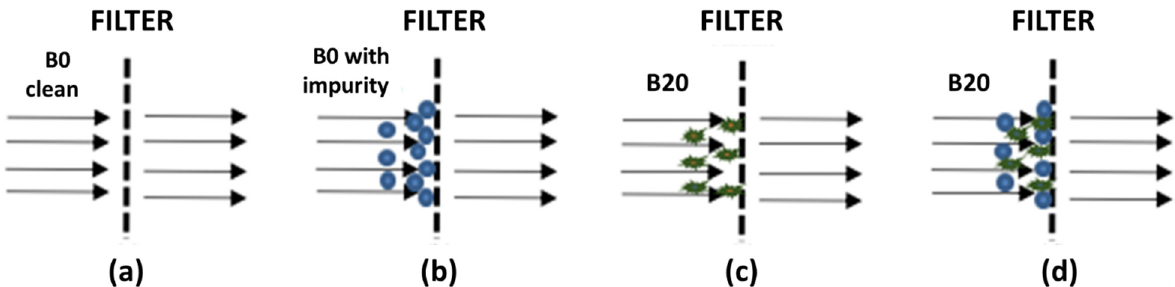
Figure 2. The flow of fuels containing different types of impurities: ( a ) clean B0 fuel, ( b ) solid test powder impurities in the B0 fuel, ( c ) precipitate impurity in B20 fuel, and ( d ) mixed test powder and precipitate impurities in B20 fuel.